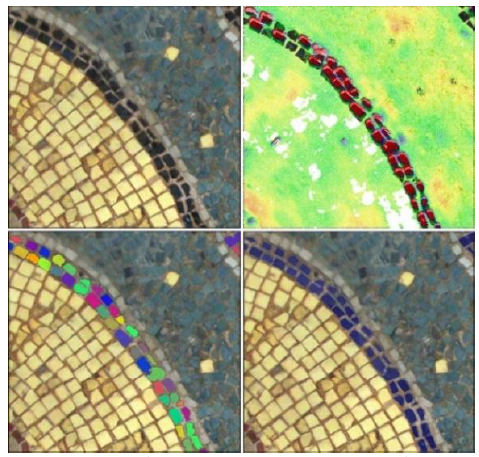
Figure 15 Classification and Semantization of dark